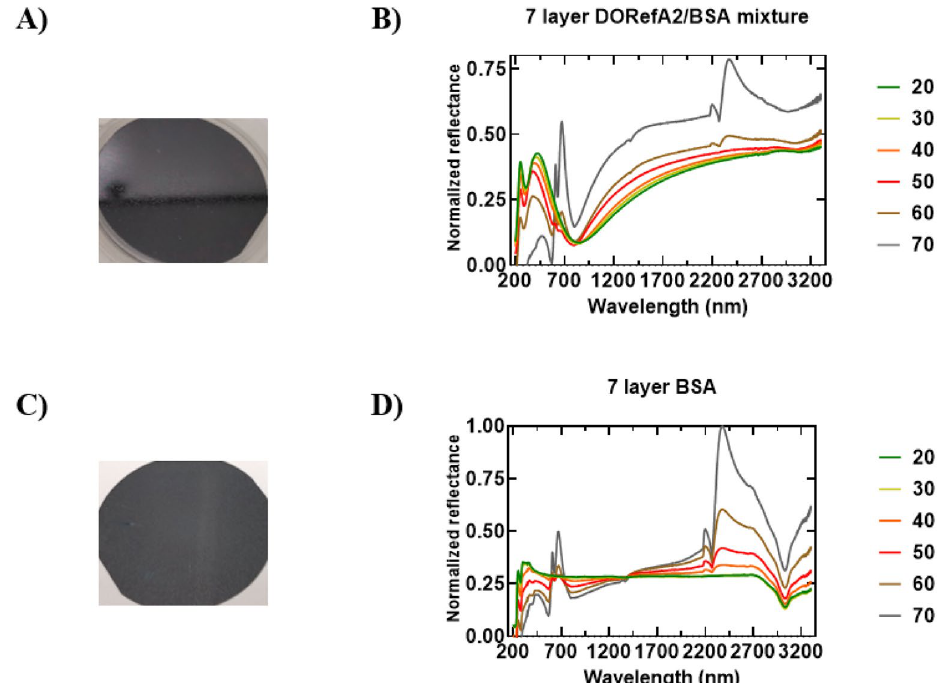
Figure 7. ( A ) Optical image of DORefA2/BSA 7 layered film following fabrication by spin coating 7 layers of a 1:1 mixture of DORefA2 (1% w/w in HFIP):BSA (1% w/w in HFIP) onto a clean Si wafer. Camera images were taken following drying. ( B ) Corresponding UV–Vis–NIR reflectance spectra (185–3300 nm). The angle of incidence was varied between 20° and 70° (10° intervals). ( C ) Optical image of BSA 7 layered film following fabrication by spin coating 7 layers of BSA (1% w/w in HFIP) onto a clean Si wafer. Camera images were taken following drying. ( D ) Corresponding UV–Vis–NIR reflectance spectra (185–3300 nm). The angle of incidence was varied between 20° and 70° (10° intervals).